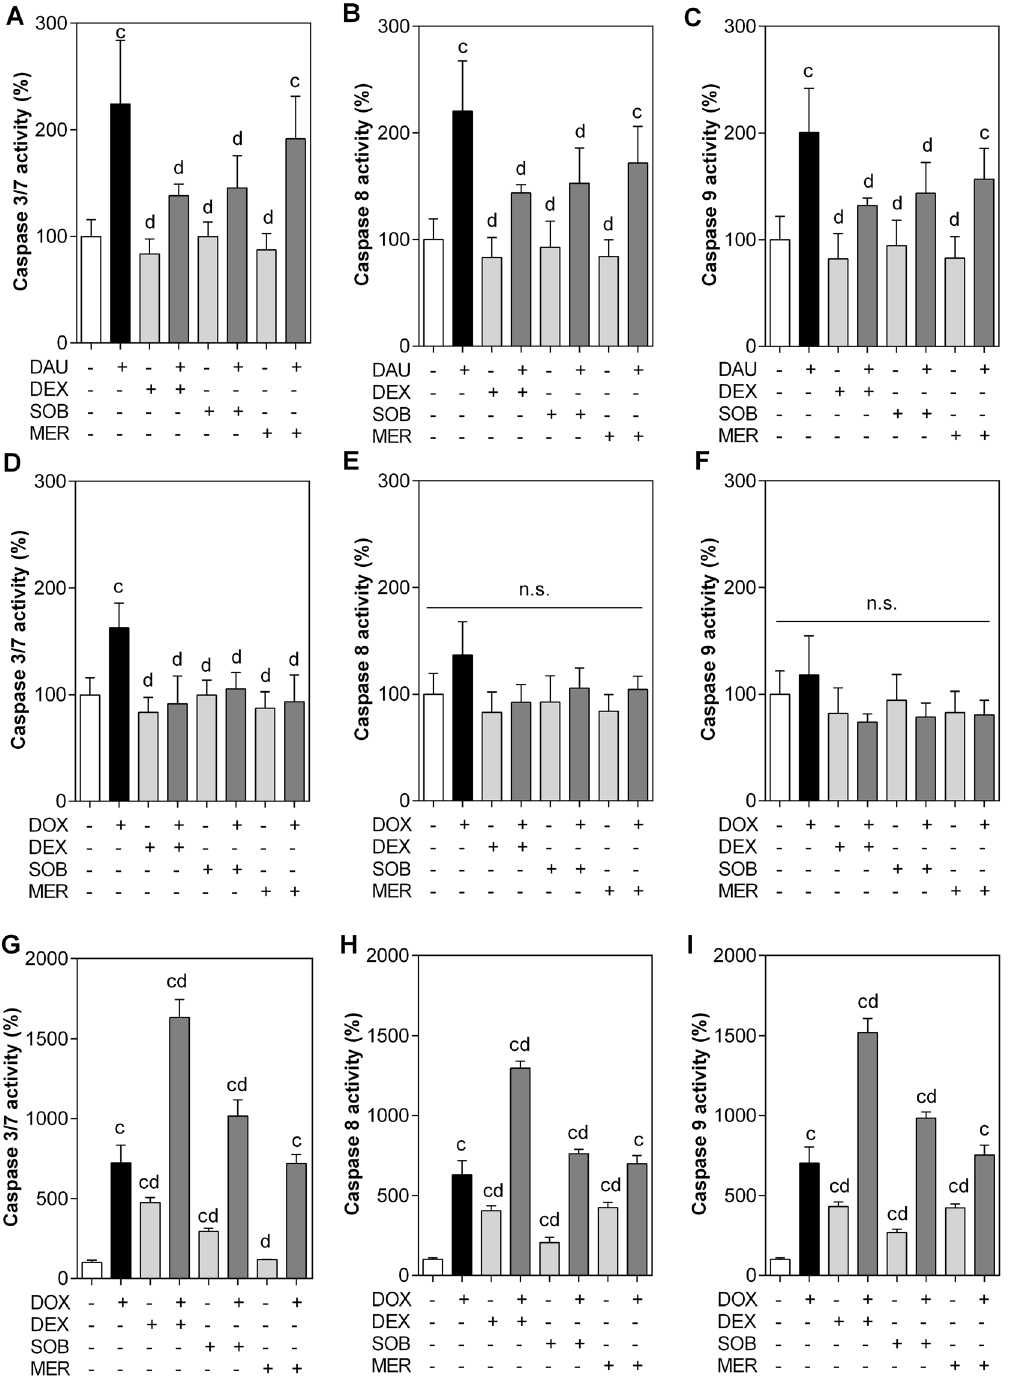
Figure 5. Caspase activities in cardiomyocytes and the HL-60 cell line. Neonatal rat cardiomyocytes (A - F) were pre-incubated with 30 m M dexrazoxane (DEX), sobuzoxane (SOB) and merbarone (MER) for 3 h and then co-incubated with 1.2 m M daunorubicin (DAU; A - C) or doxorubicin (DOX; D - F) for 3 h, followed by an anthracycline-free 48-h period. The HL-60 cell line (G - I) was co-incubated with 25 m M DEX, 38 m M SOB, 48 m M MER and 19 nM doxorubicin (DOX) for 72 h. The activity of caspases 3/7 (A, D, G), 8 (B, E, H) and 9 (C, F, I) was assessed with a chemiluminescence assay as described in the materials and methods, corrected for protein content and expressed as the percentage of untreated control cells (100%). Data from $ 4 experiments are expressed as the mean 6 SD, statistical significance c – compared to control; d – compared to DAU or DOX; n.s. – not significant (one-way ANOVA with Dunnett’s post-test, P # 0.05). doi:10.1371/journal.pone.0076676.g005 to control from the start of incubation. DEX also increased to , 30% of the levels achieved with SIH. Moreover, a substantial significantly the calcein fluorescence compared to control, but only lag-time was noticed as significant change in fluorescence